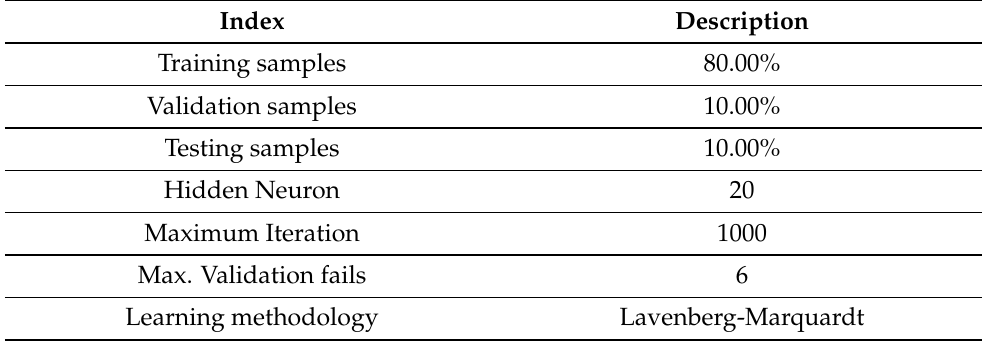
Table 2. Parameters settings for the execution of the design NN-LMT.